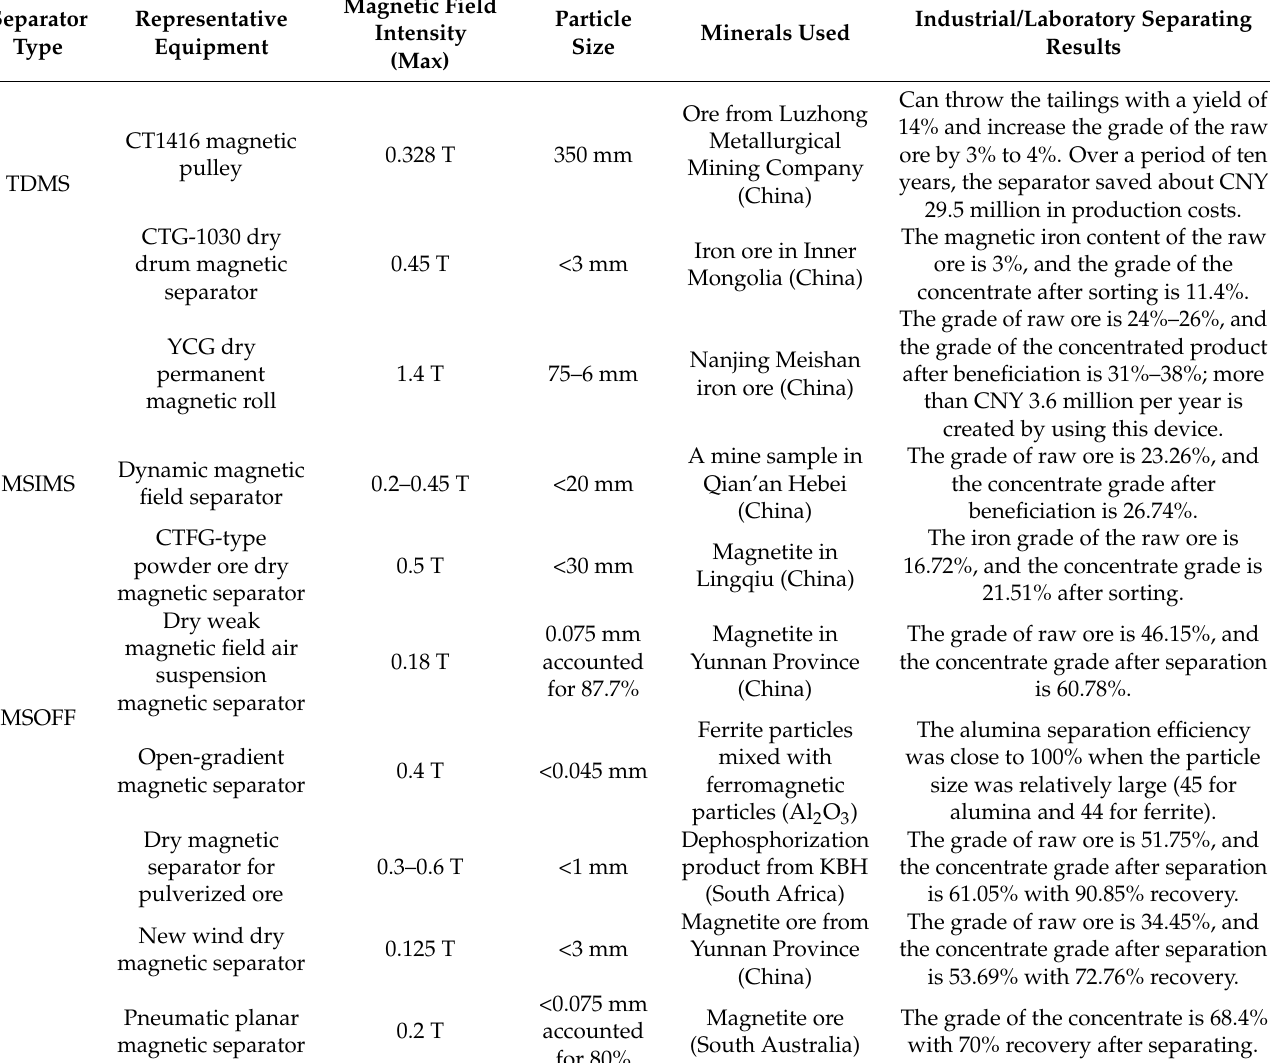
Table 1. Comprehensive summary of the dry permanent